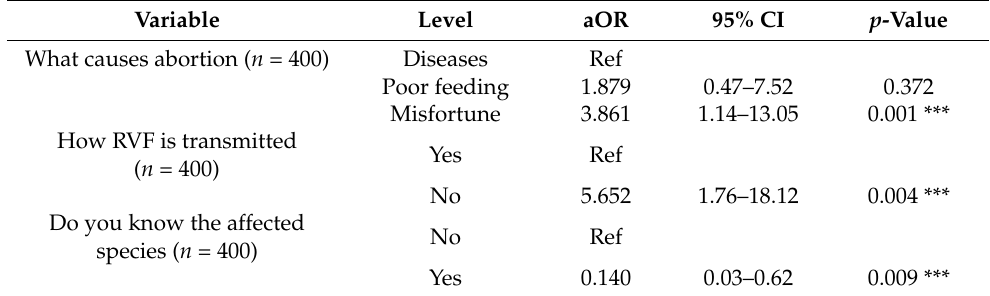
Table 8. Summary of maximum-likelihood estimates for predictors associated with RVF knowledge. Variable Level aOR 95%